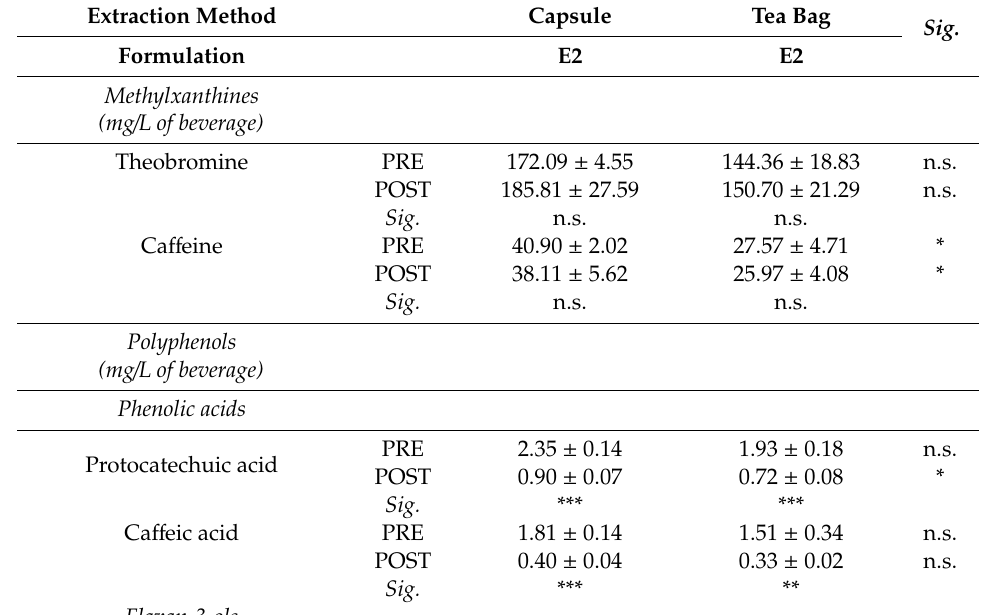
Table 4. Values (mean ± standard deviation) of methylxanthines and identified polyphenols before (PRE) and after (POST) in vitro gastrointestinal digestion for capsule and tea bag coconut flavored beverages (E2) and results of ANOVA. Significance is reported for each compound between PRE and POST in vitro gastrointestinal digestion within the same extraction technique (column) and for each compound both PRE- and POST- in vitro gastrointestinal digestion between the two extraction methods